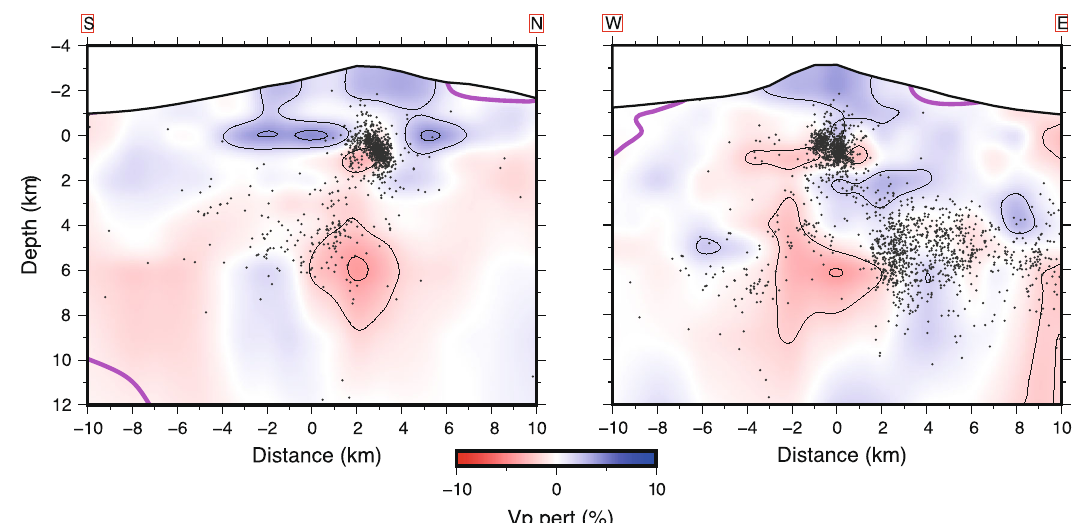
Fig. 5 Time-lapse tomography at Mt. Etna. S-N and W-E vertical sections of Vp changes crossing the volcano similar to those of (Fig. 3b) but done following the Foulger approach 25 .